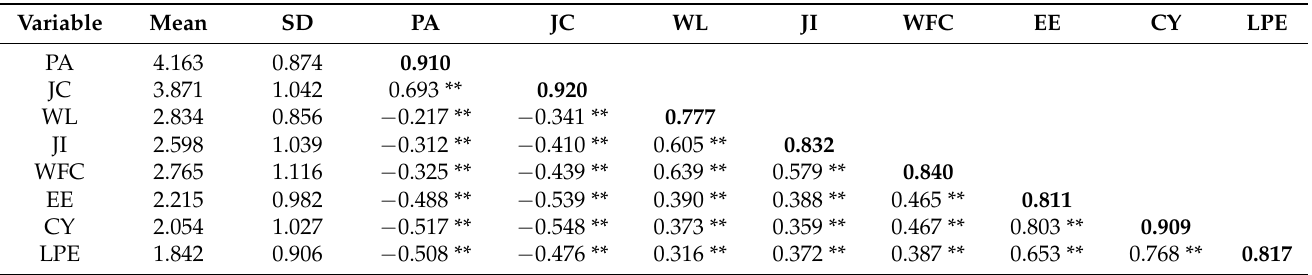
Table 4. Descriptive statistics and correlation analysis. (N =